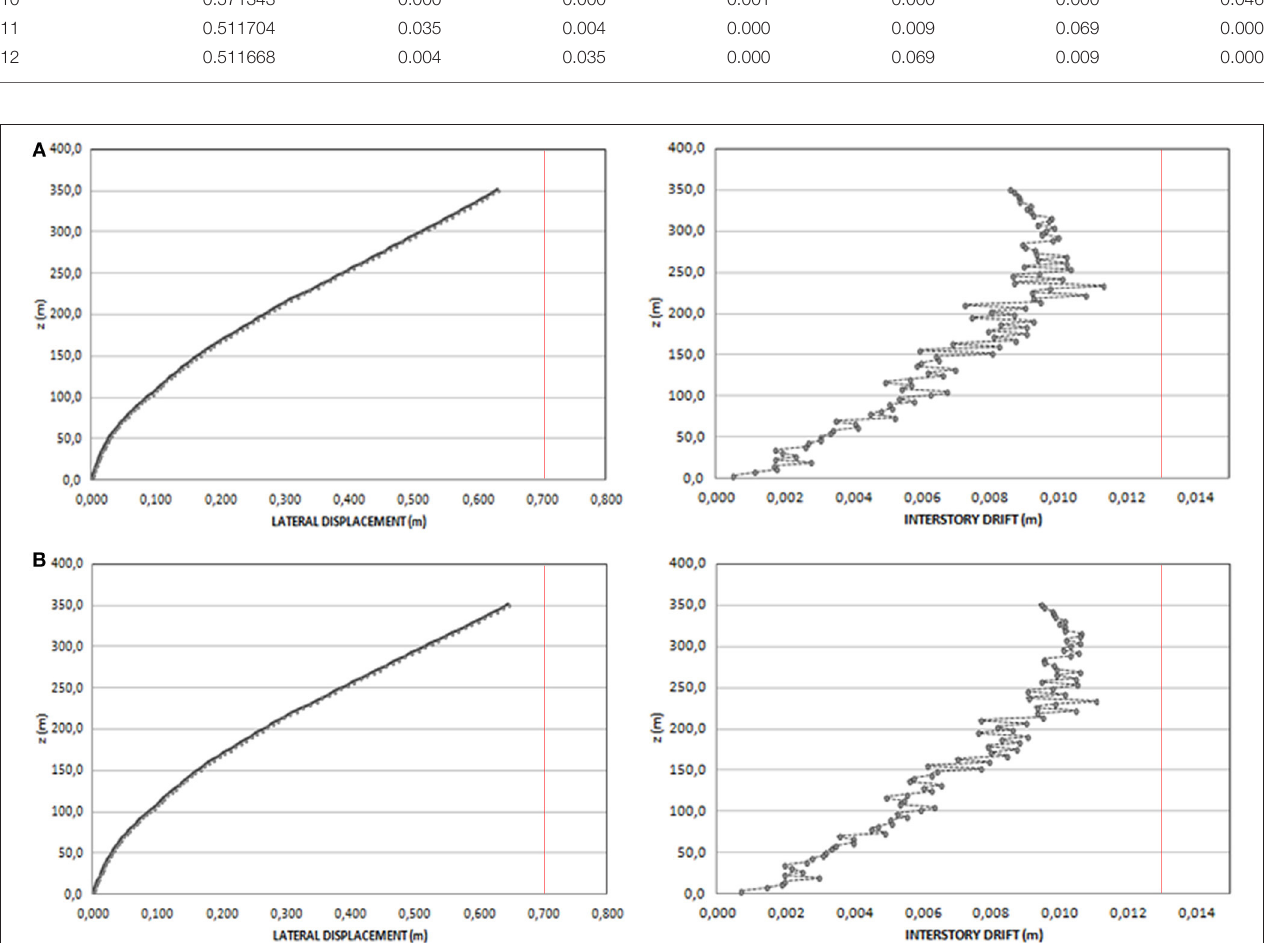
FIGURE 11 | Lateral displacements (on the left) and inter-storey drifts (on the right) under seismic load: varying density Voronoi pattern with constant cross-sections (A) and optimized cross-sections (B)